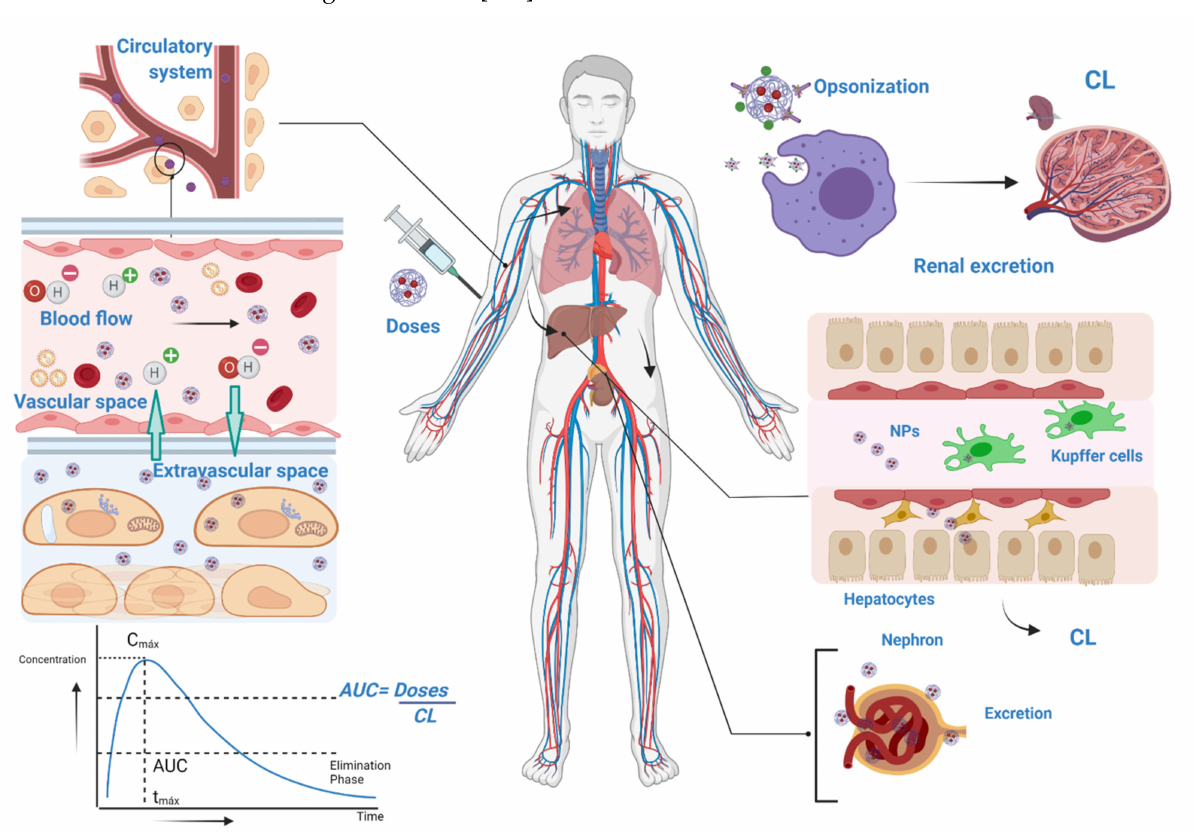
Figure 9. PK parameters for nanomedicines. Analyzing pharmacokinetics as a whole is a key com- ponent to understanding the biodistribution of NPs. Nanoparticles enter cells by passive transport such as red blood cells and directly depend on the size of the NPs, being only possible for sizes below 200 nm. Opsonization begins once the NPs enter the organism, and opsonins bind to the NPs and present them to the mononuclear phagocytic system (MPS). The rapid response of the MPS and the reticuloendothelial system (RES) results in the elimination of NPs within a few hours after injection, and they do not reach the target tissue. The uptake is dose-dependent, and it is challenging to understand the effect of dose on the system. Performing a quantitative biodistribution allows the assessment of their distribution in organs and tissues of interest, regardless of the route of administration. The largest accumulations of NPs occur in the blood, liver, and spleen. Created with BioRender.com (accessed on 10 December